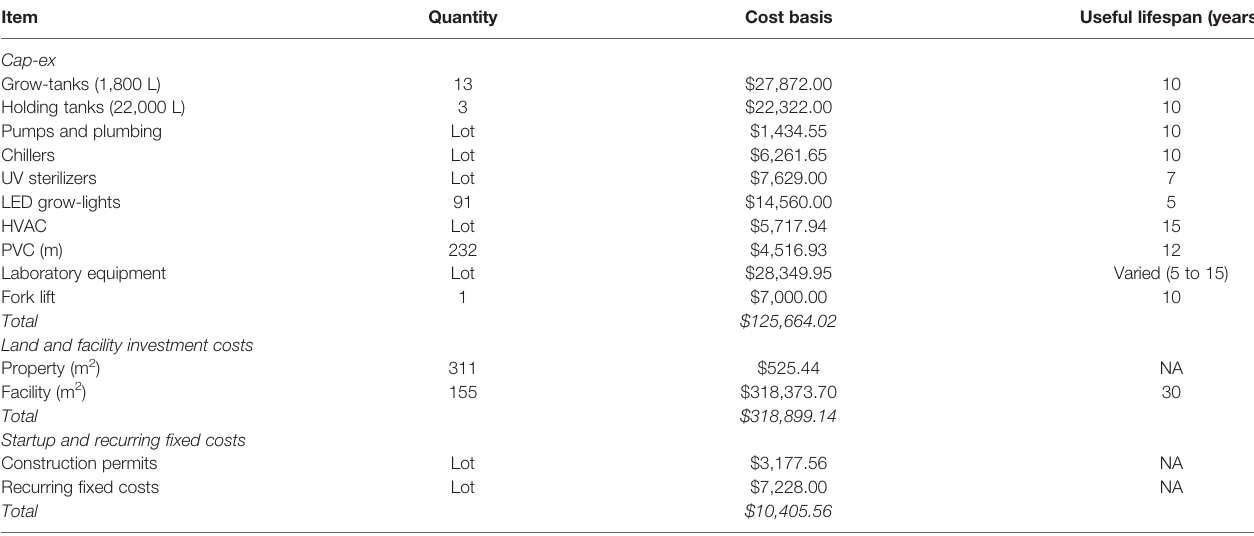
TABLE 1 | Summary of fi xed costs ( FC ) included in the baseline techno-economic model (101,880 m of twine produced annually).